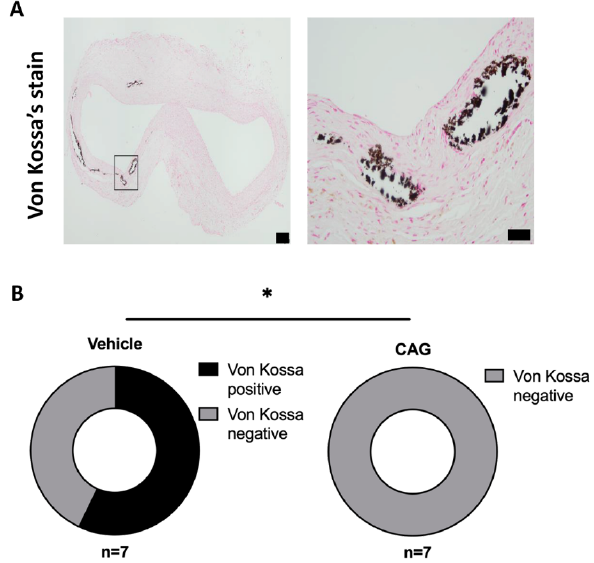
Figure 8. The effect of CAG treatment on aneurysm calcification. ( A ) Representative micrographs of calcium deposits (Black) in the aneurysm wall visualized by Von Kossa’s staining (enlargement represent black square on the left image). Scale bar (black box) in micrograph to the left: 100 µm and in micrograph to the right: 50 µm. (n = 7/7). ( B ) Donut plot of percentage of Von Kossa’s positive aneurysm sections in CAG and vehicle treated groups (n = 7/7; p = 0.018). All values are median ± interquartile range. All RNA data is normalized to RPL41 mRNA levels. * Indicates p <